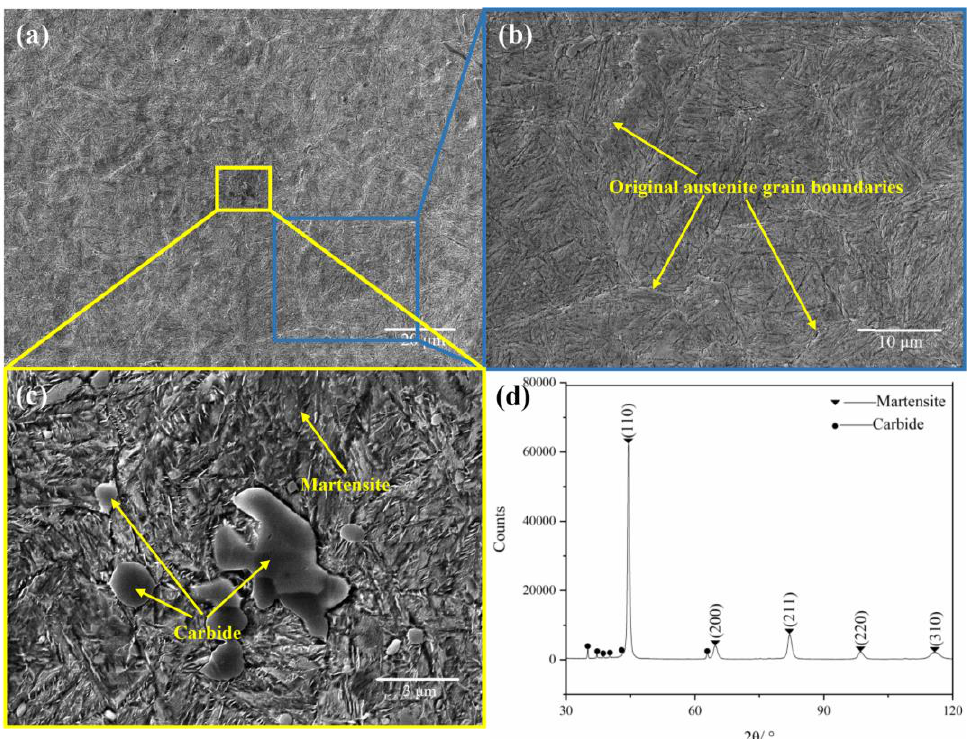
Figure 2. Microstructure of the Cr4Mo4V steel. ( a ) Low magnification; ( b ) a magnified image of ( a );